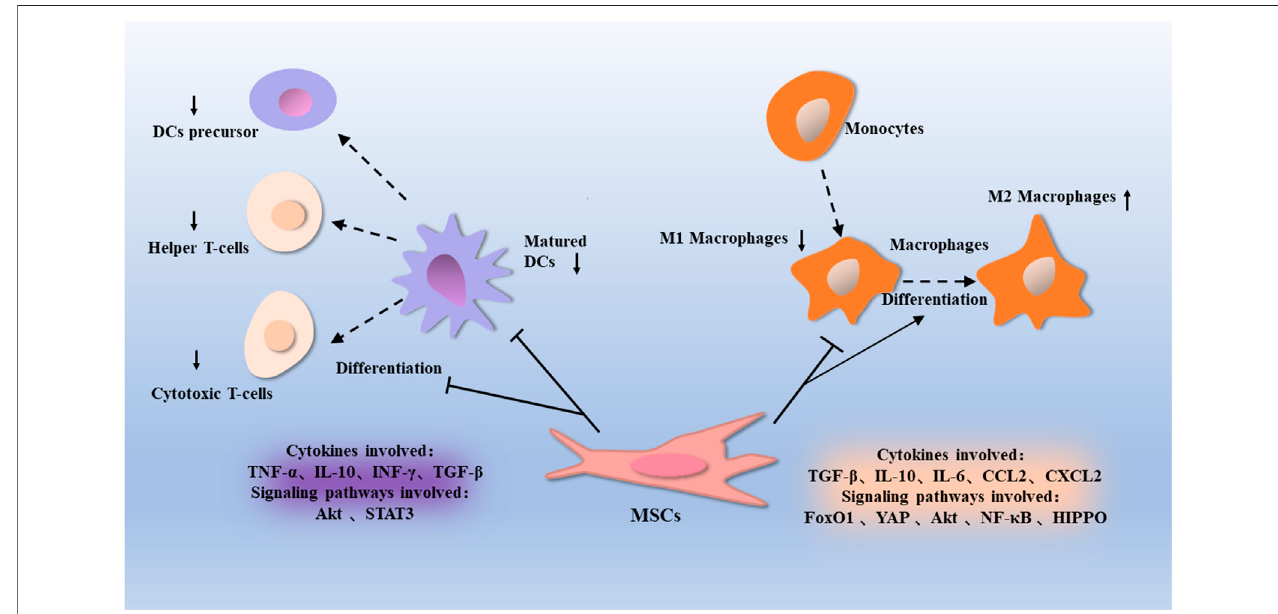
FIGURE 1 | Macrophages are a type of immune cells that differentiate from differentiated monocytes derived from MSCs. MSCs inhibit macrophages activation through proteins such as Akt, FoxO1, NF- κ B, and Hippo, can promote the conversion of macrophages from a pro-in fl ammatory M1 phenotype to an anti-in fl ammatory M2phenotype.ThisisassociatedwithfactorssuchasTGF- β ,IL-10,IL-6,CCL2,andCXCL2.Dendriticcellsaredifferentiatedfromdendriticcellprecursorsandregulate theconversionofTcellstohelperTcellsandcytotoxicTcells.MSCsinhibittheproliferationofdendriticcellsthroughproteinssuchasAktandSTAT3,thusaffecting their regulatory T-cell function, which is associated with factors such as TNF- α , IL-10, INF γ , and TGF- β .